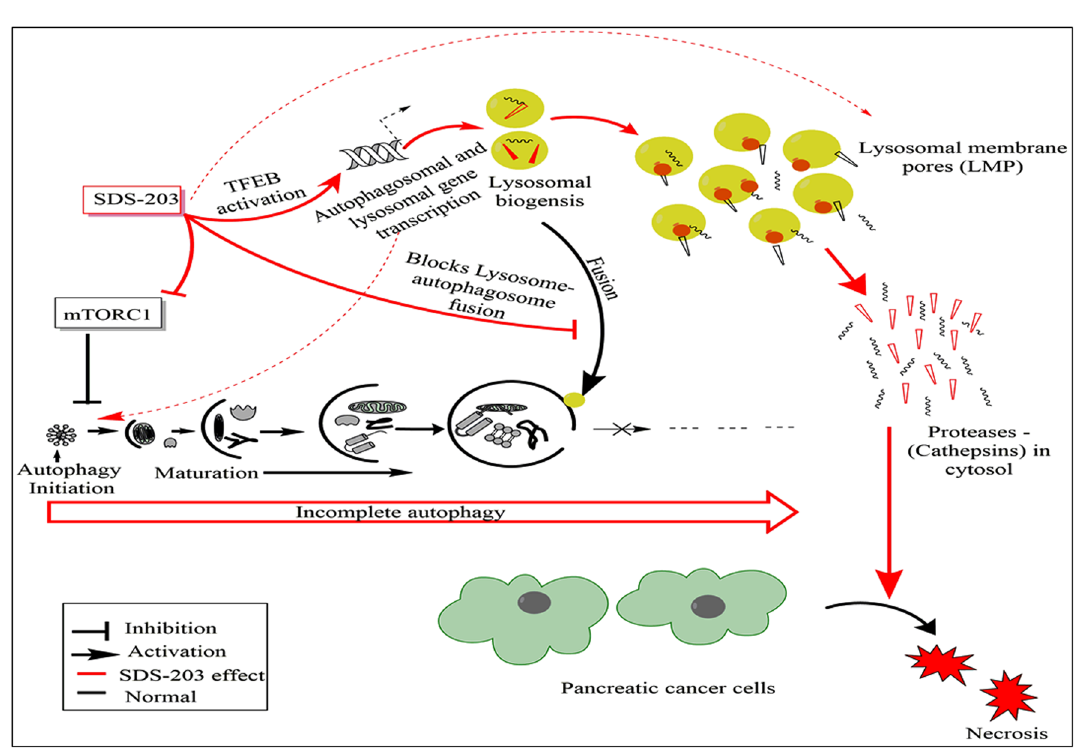
Figure 9. Image representing the effect of SDS-203 on various pathways in pancreatic adenocarcinoma. A schematic diagram represents the potential role of SDS-203 in inhibiting the mTORC1 activity and autophagosome–lysosomal fusion. mTORC1 inhibition translocates the cytosolic TFEB into the nucleus which in turn activates the transcription of lysosomal-related genes resulting in the over synthesis and activation of lysosomal enzymes thereby commencing necrotic death in the aggressive pancreatic cancer cell MIA PaCa-2. This representation has been made with the help of the software ChemBioDraw Ultra